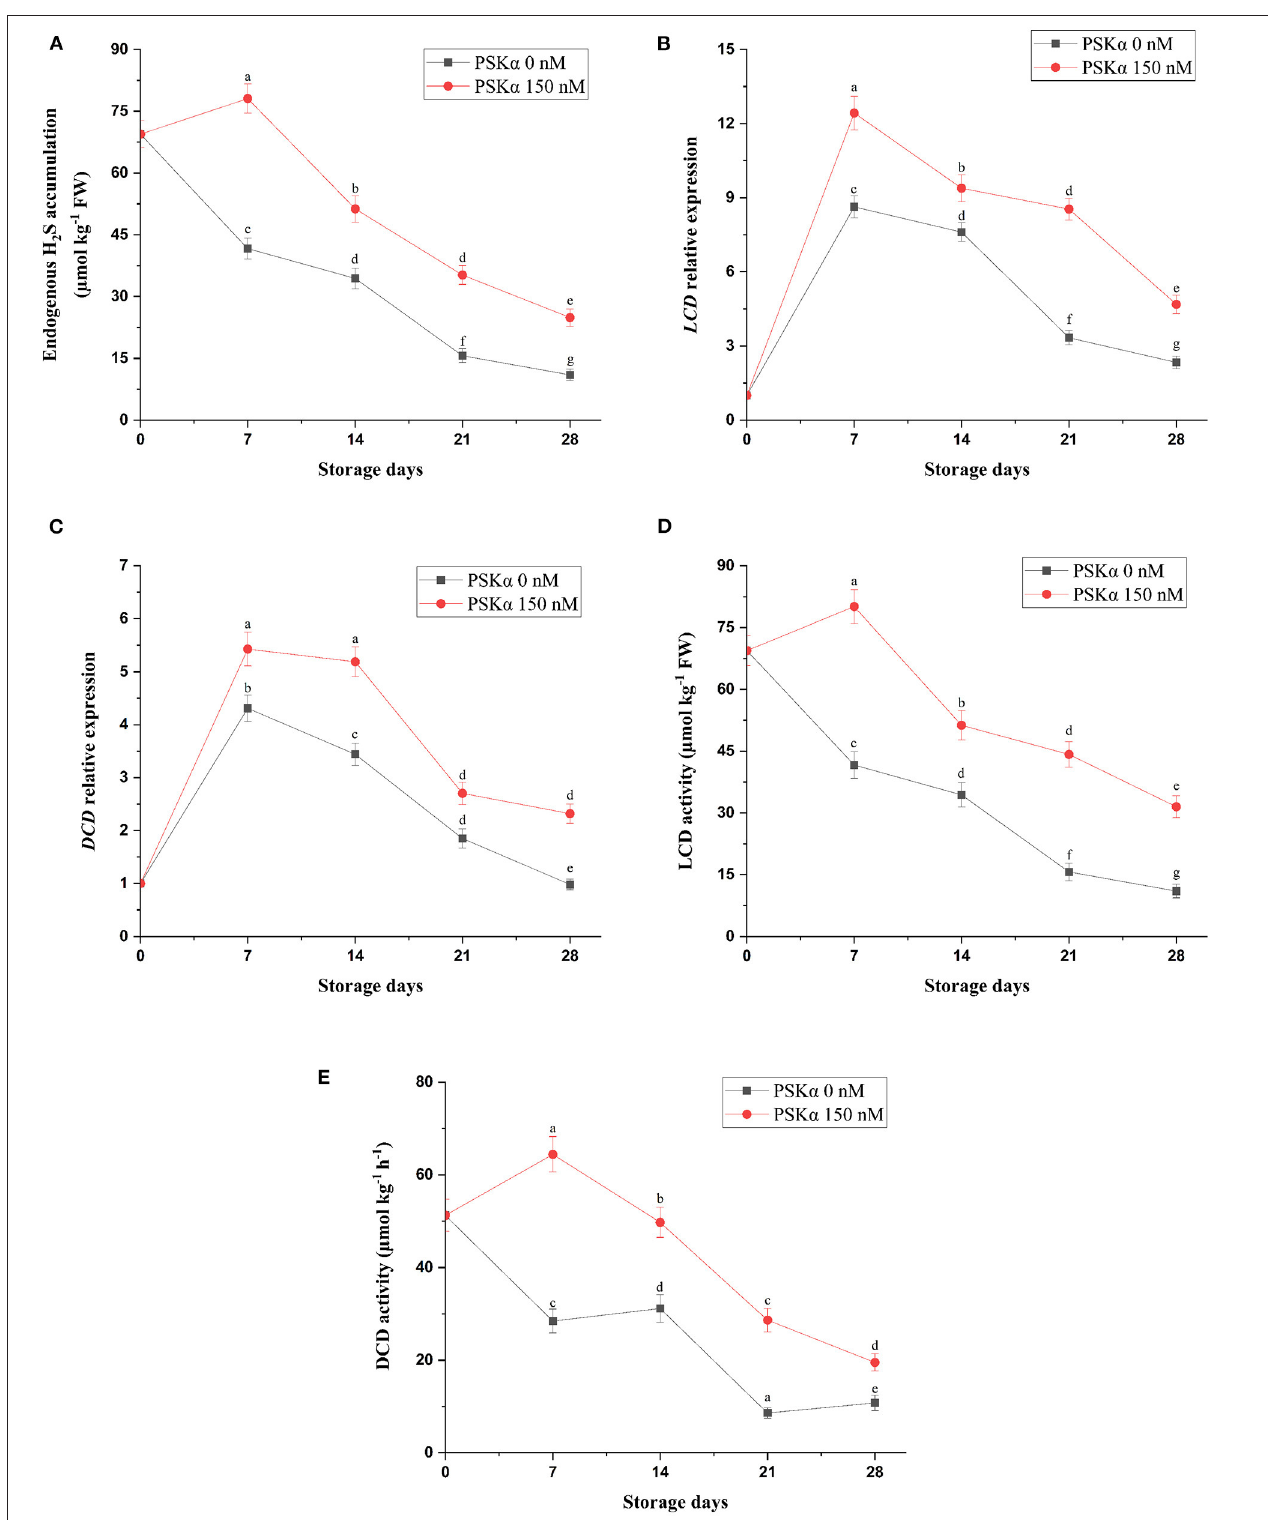
FIGURE 3 | Endogenous H 2 S accumulation (A) accompanied by LCD and DCD gene expressions (B,C) and enzyme activities (D,E) in broccoli floret treated with PSK α at 0 and 150nM during storage at 4 ◦ C for 28 days. Data shown are mean values of n = 3, and the error bars represent standard errors of the means. Tukey’s test at P = 0.05